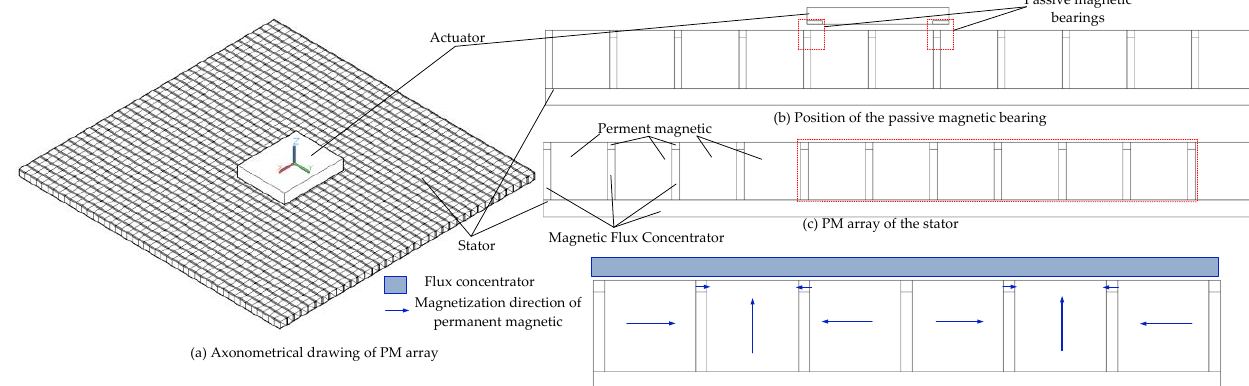
Figure 4. Structure of the PM array.